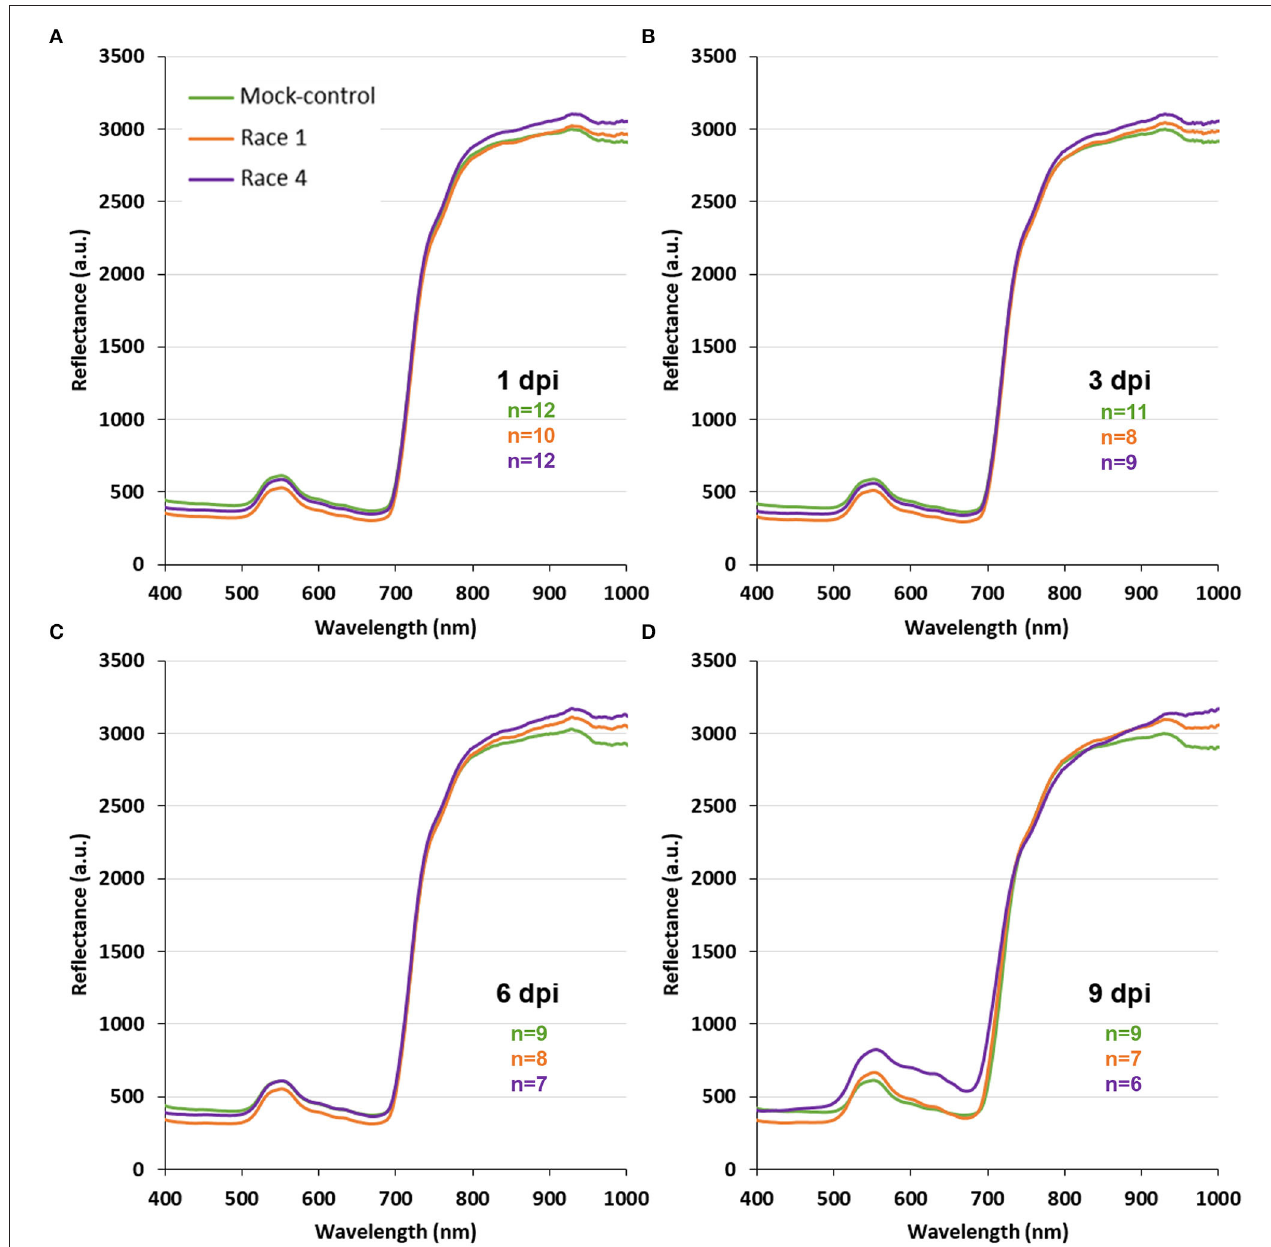
FIGURE 2 | Spectral profiles of whole leaves of mock-control, Xcc race 1-infected, and Xcc race 4-infected broccoli plants at current climate conditions and at different days post-inoculation (dpi). Graphs represent mean values for every treatment. Sample size ( n ) is given for each timepoint and treatment: mock-control (green); Xcc race 1-infected (orange); and Xcc race 4-infected broccoli plants (purple). A, B, C , and D : 1, 3, 6, and 9 dpi, respectively.